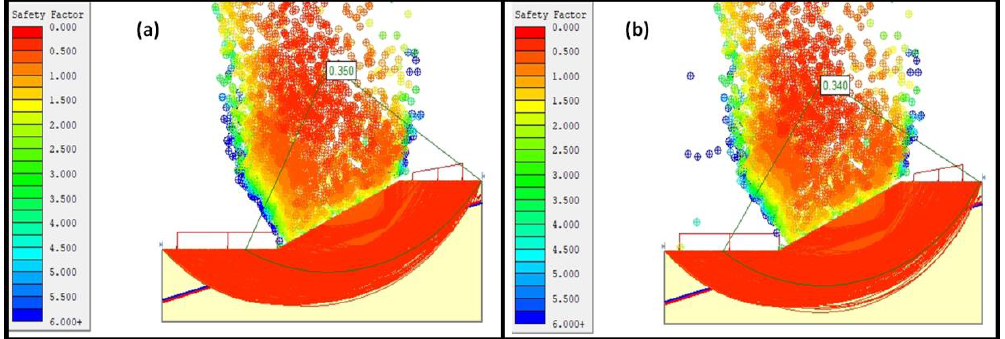
Figure 20. Safety factor simulated for rainy conditions in silt clay soil slope using ( a ) Spencer’s method and ( b ) Corp of Engineers’ Number One method .